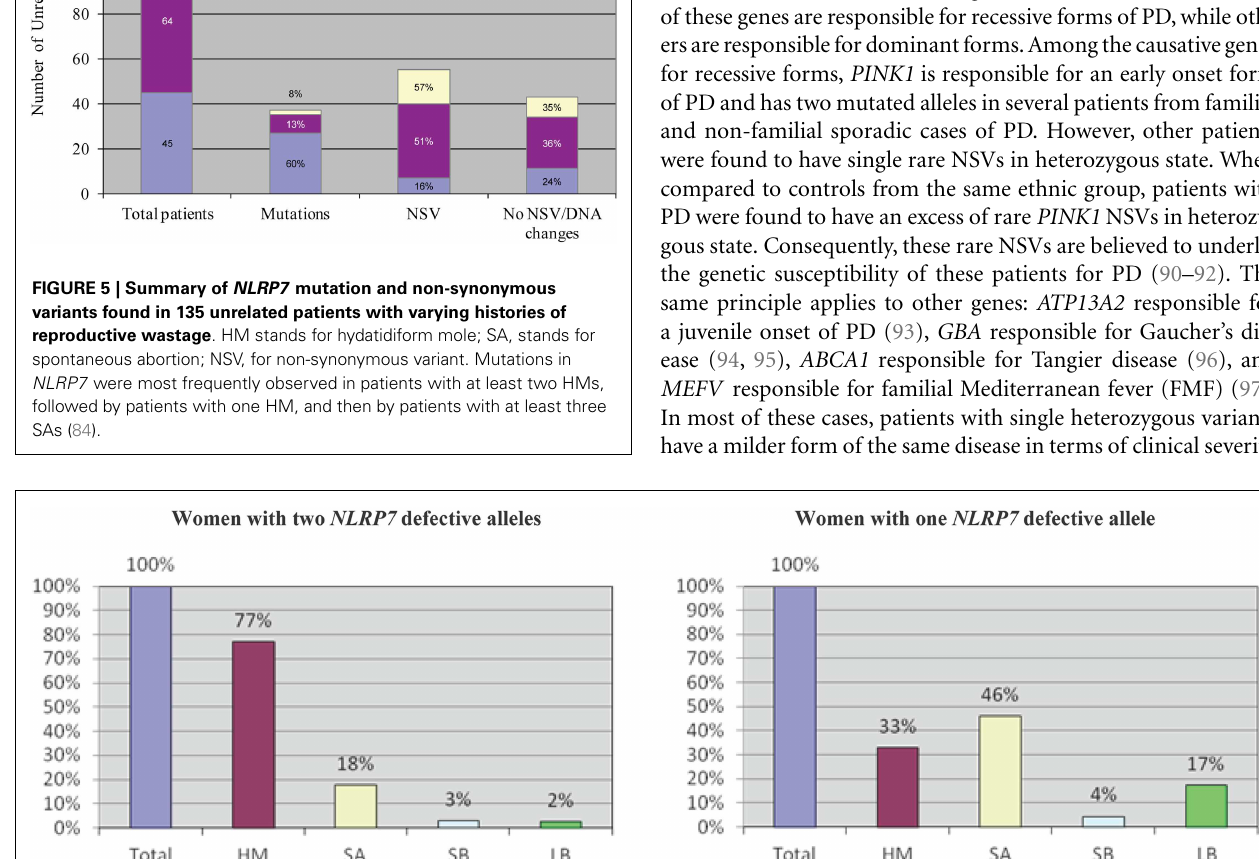
FIGURE 6 |A comparison of reproductive outcomes between women with two or one defective NLRP7 allele . In both histograms, n indicates the total number of pregnancies from patients in either category. HM,